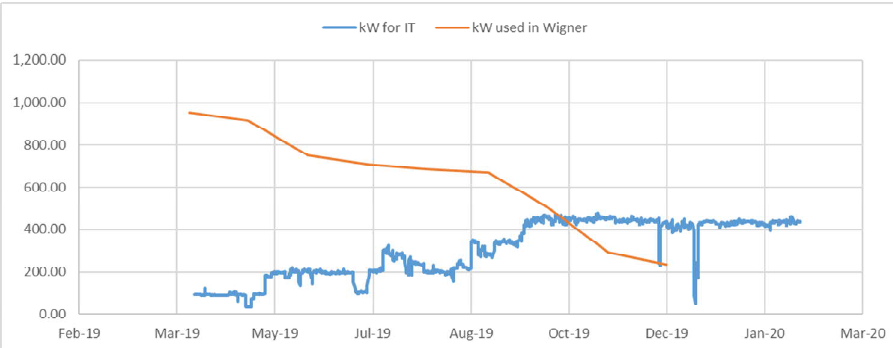
Figure 4: Power consumption (kW) in first LHCb compute module (blue line) and in co-location facility (orange